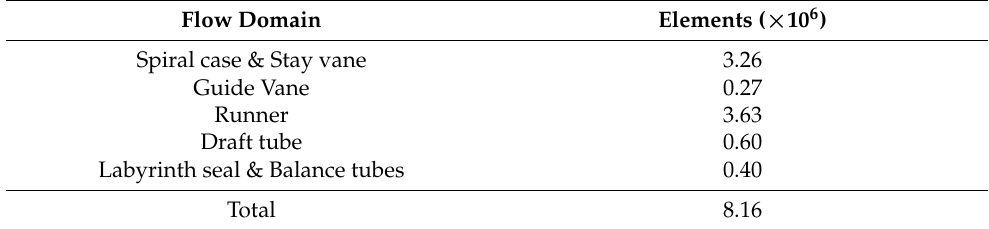
Table 2. Element number of flow domains.